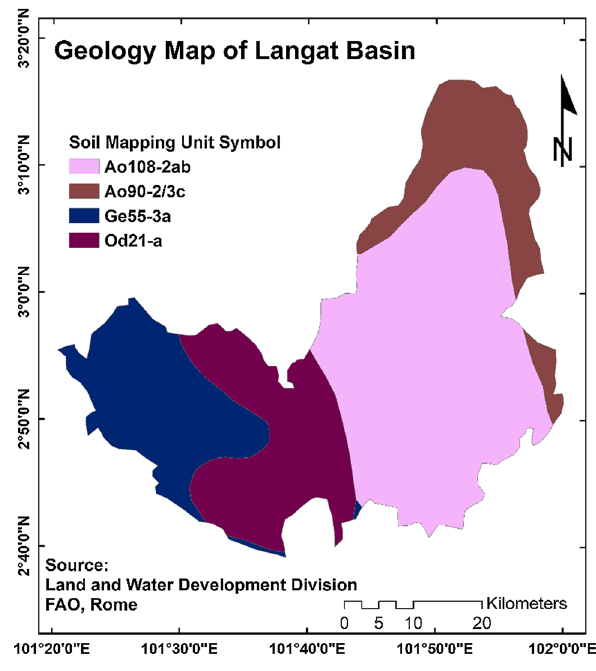
Fig. 2 Geology map